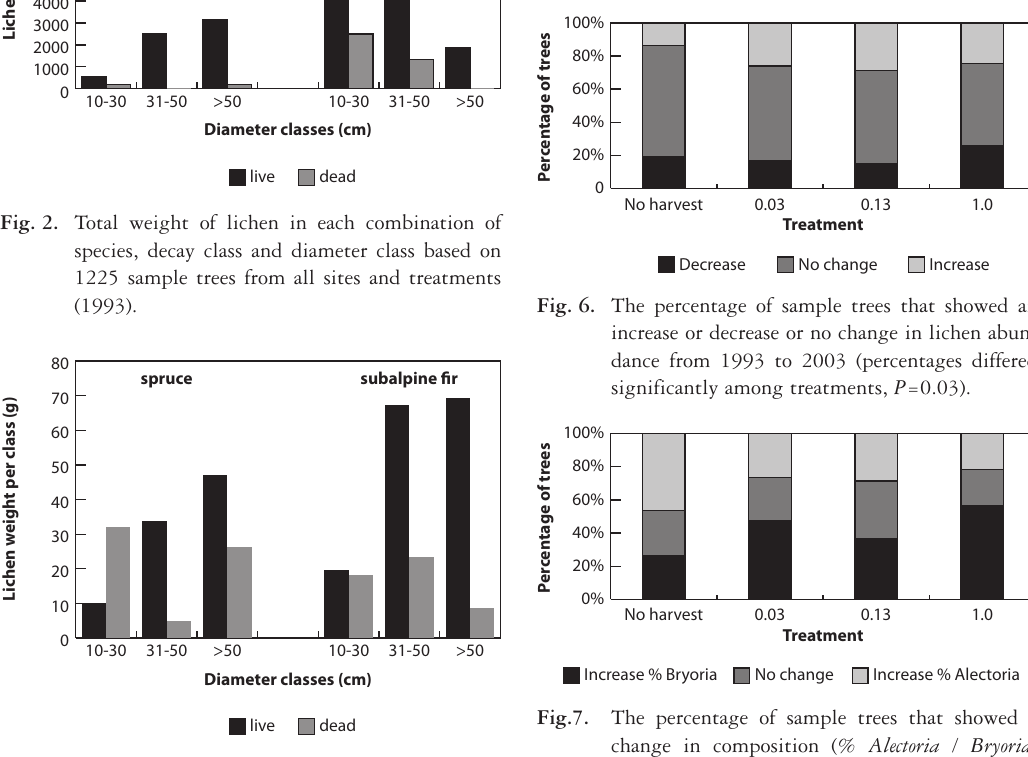
Fig. 3. Mean weight of lichen per tree in each combination of species, decay class and diameter class.